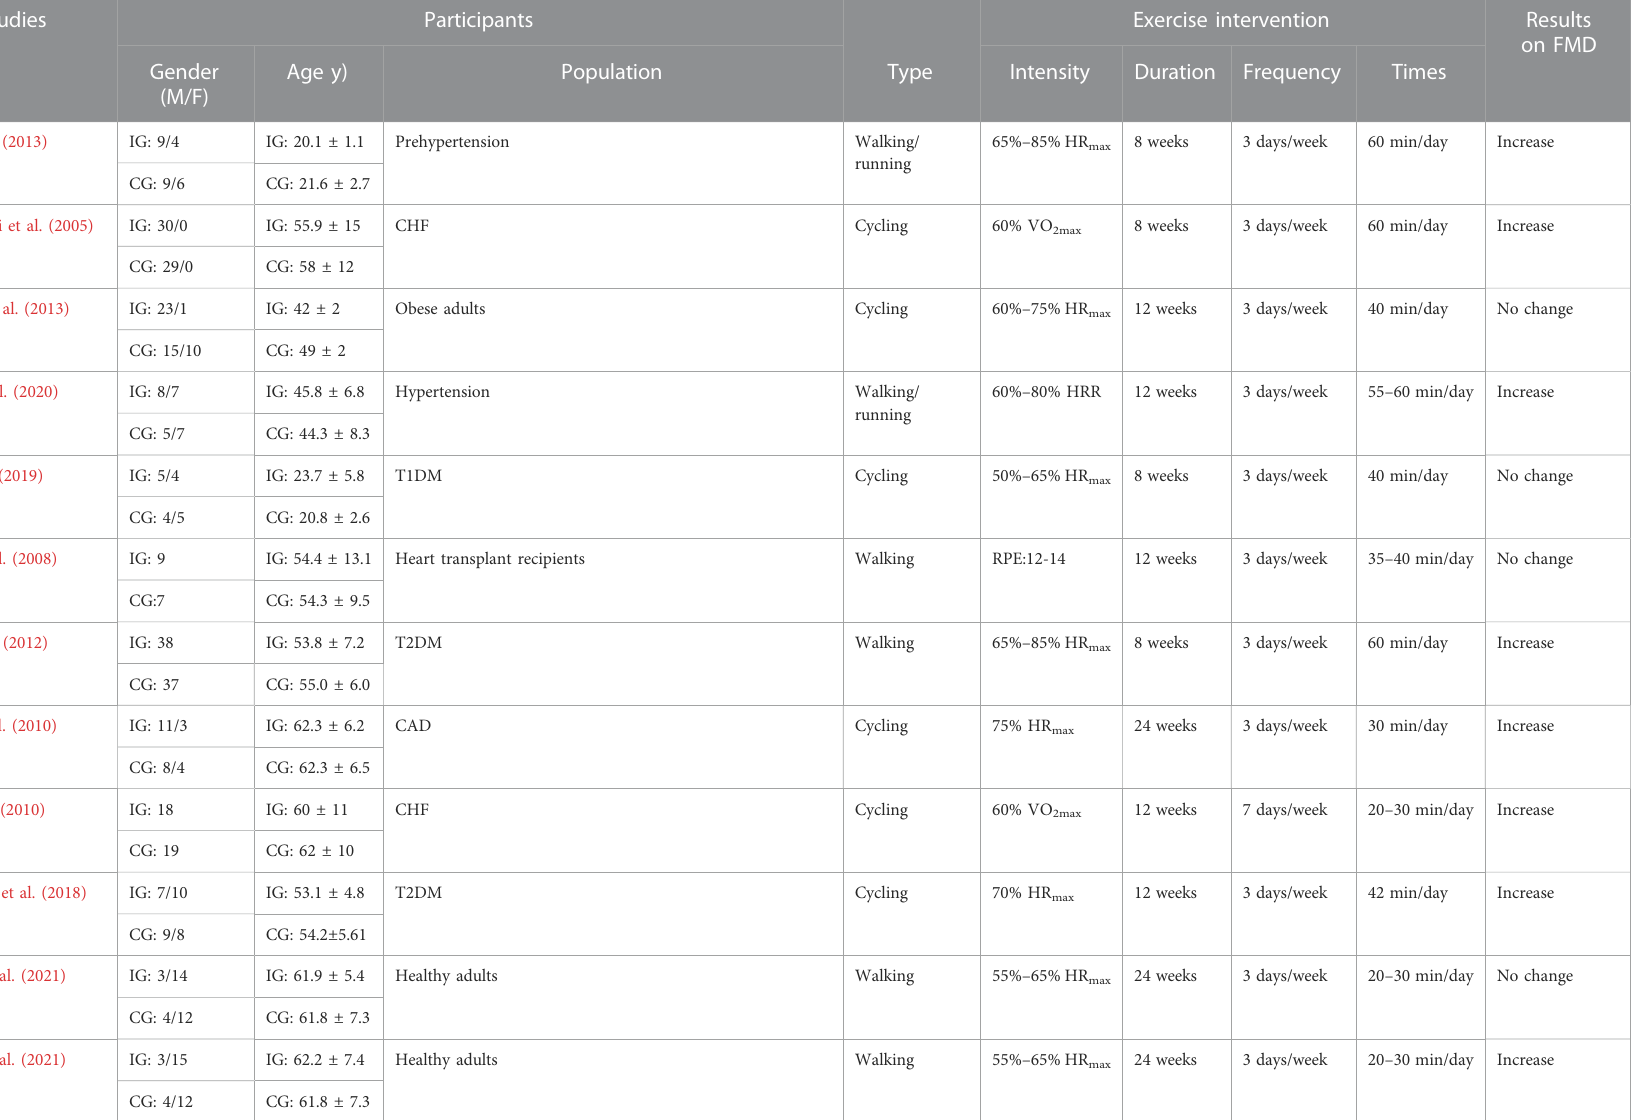
TABLE 1 Characteristics of included study